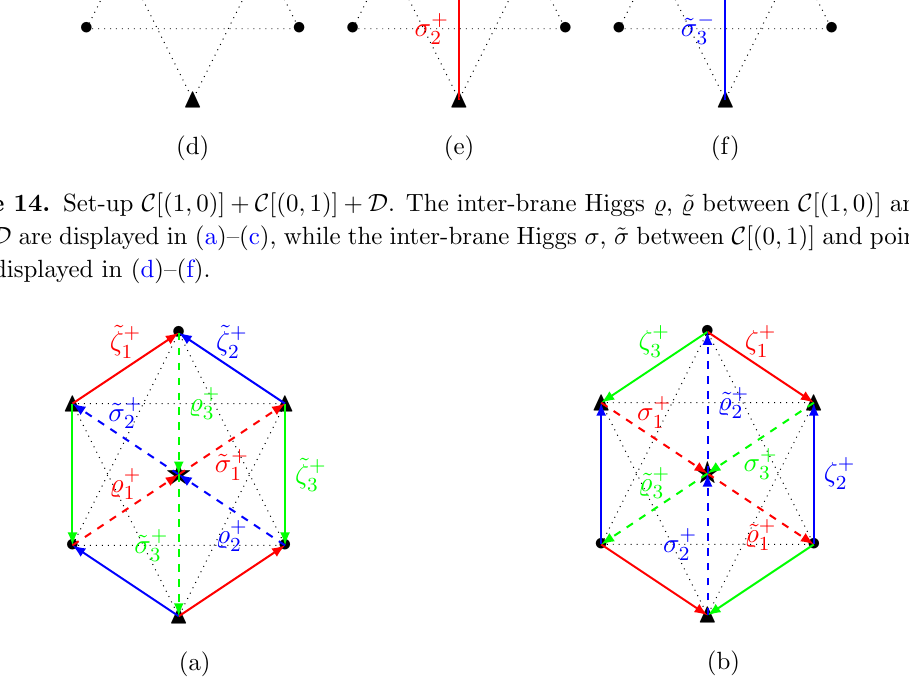
Figure 15. Set-up C [(1 ; 0)] + C [(0 ; 1)] + D . By turning on various intra-brane zero modes, we